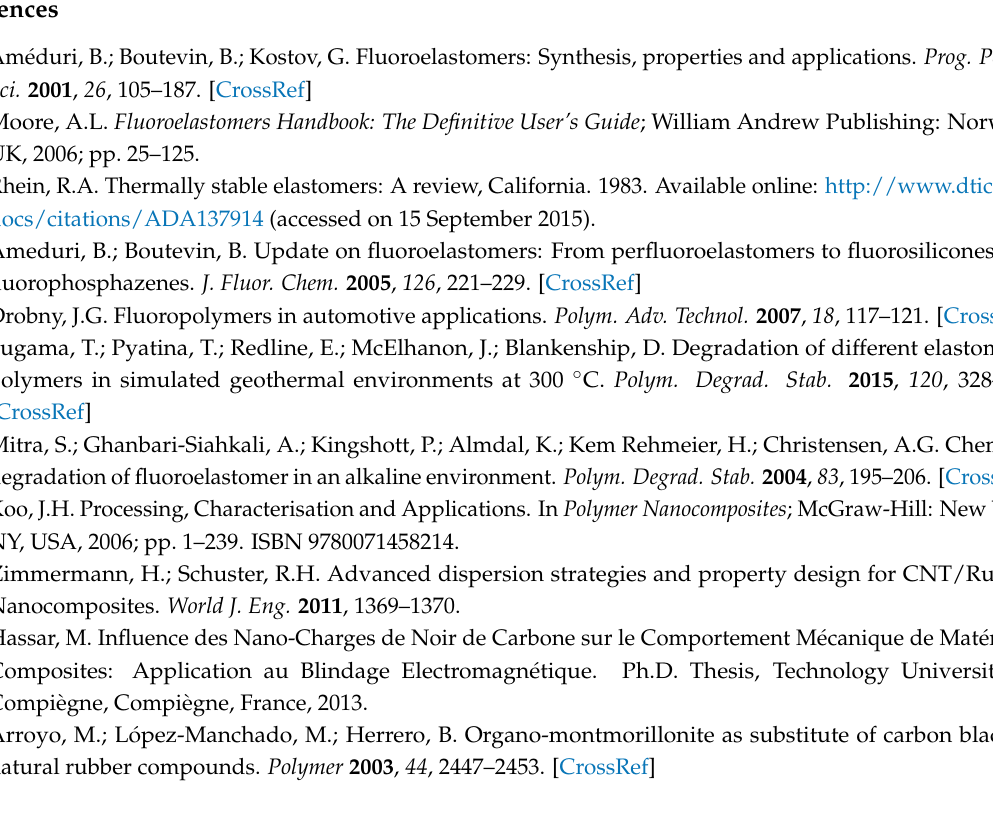
s1, Figure S1: SEM micrographs of FKM polymer film (F), Figure S2: SEM micrographs of FR film, Figure S3: TEM micrographs of (a) POSS-A, (b) POSS-P, and (c) POSS-F nanoparticles, Figure S4: TEM micrographs of FKM polymer film (F), Figure S5: TEM micrographs of FR film, Figure S6: EDX spectrum of the black zone observed in Figure S5, for FR mixture, Figure S7: EDX spectrum of the black zone observed in Figure S5, for FR mixture, Figure S8: DSC curves of POSS nanofillers: (a) POSS-A, (b) POSS-P and (c) POSS-F, Figure S9: TGA curves of FKM polymer (F) under air and nitrogen, Figure S10: TGA curves of F R under air and